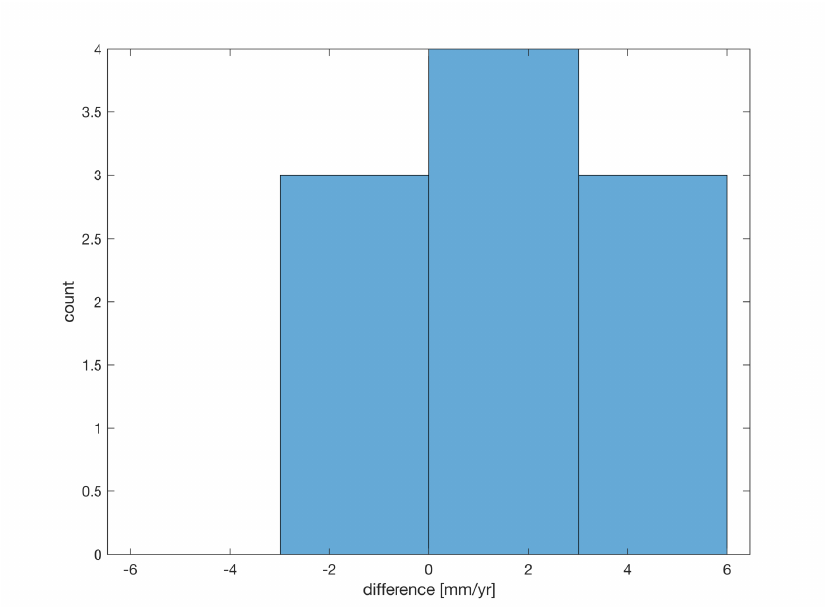
Figure 8. Histogram of differences between range change rate at COSO with respect to COSJ estimated from GPS using linear interpolation and extrapolation and range change rates at COSO with respect to COSJ observed by Sentinel-1A pairs.